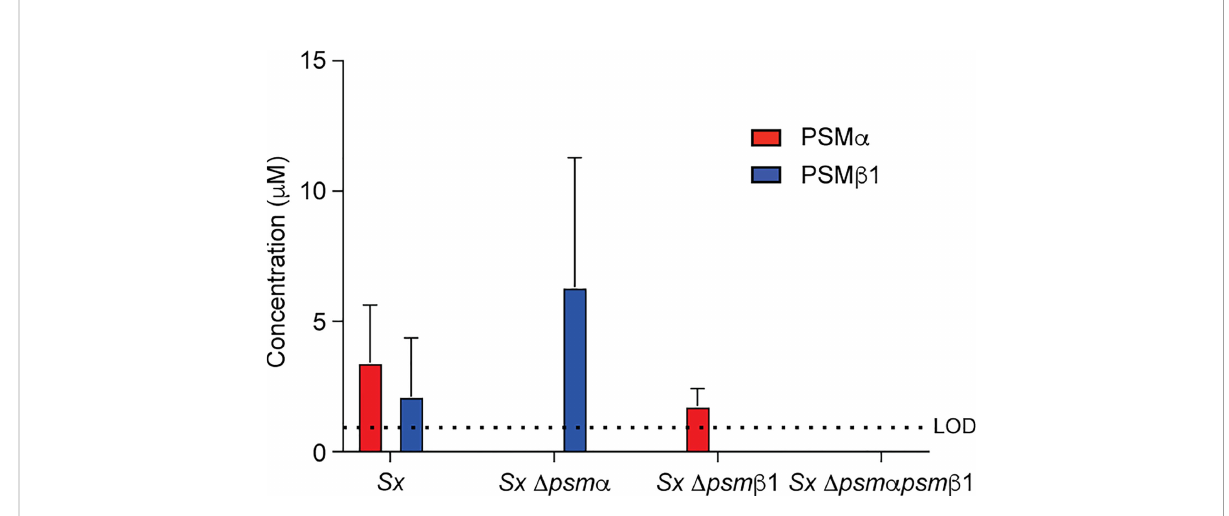
FIGURE 4 Construction of isogenic S. xylosus psm deletion and complementation strains. Analysis of PSM production pattern by RP-HPLC/ESI-MS of culture fi ltrates collected from constructed isogenic psm mutants of strain S. xylosus